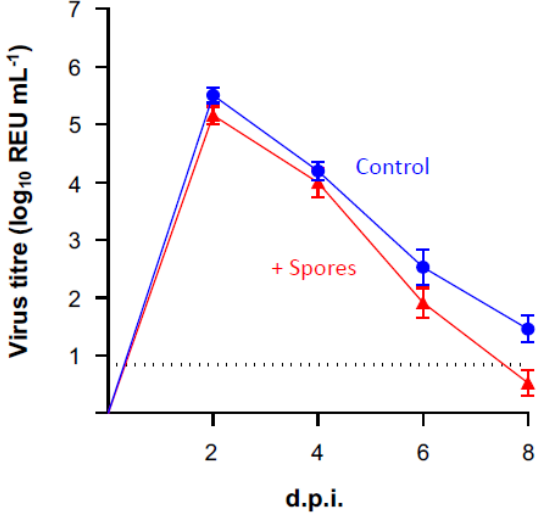
Figure 3. Viral shedding exhibited by ferrets treated with DSM 32444 K or mock-treated with PBS following infection with H7N9 AIV. Viral RNA was quantified in RNA extracted from nasal wash samples using an influenza A rRT-qPCR. Relative equivalency units (REUs) were calculated and displayed based on Cq values obtained extrapolated from a standard curve of a known titre of A/Anhui/1/13 (H7N9).